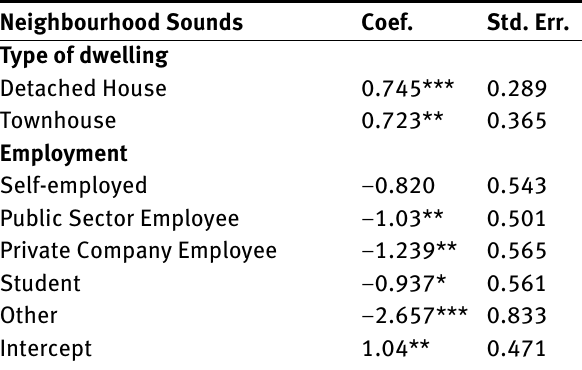
Table 20: Coeflcients of the model for the overall assessment of the environment Overall assessment of the envi-